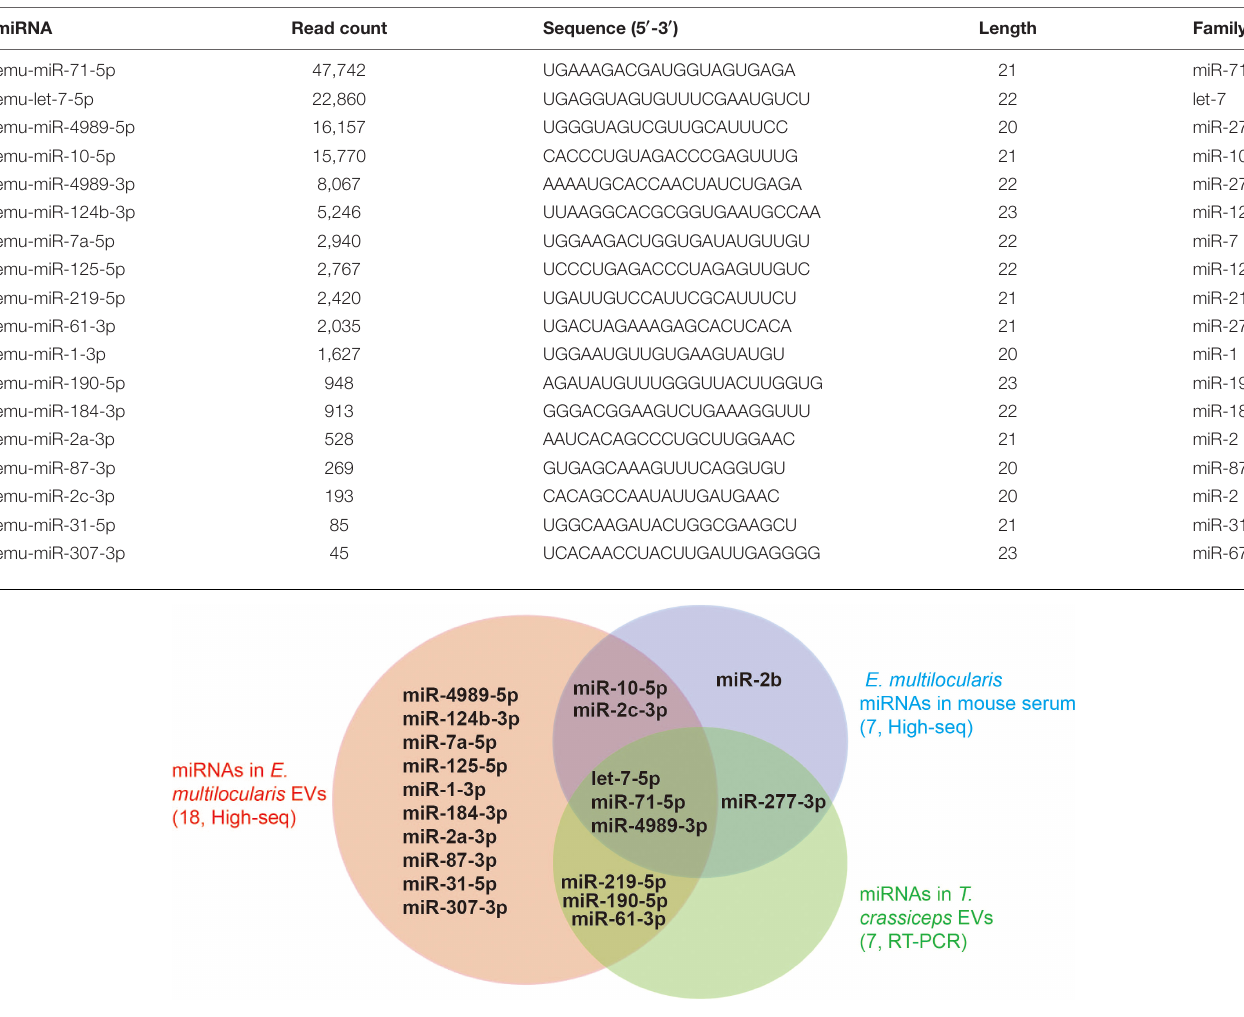
TABLE 2 | miRNAs encapsulated into E. multilocularis extracellular vesicles. miRNA Read count